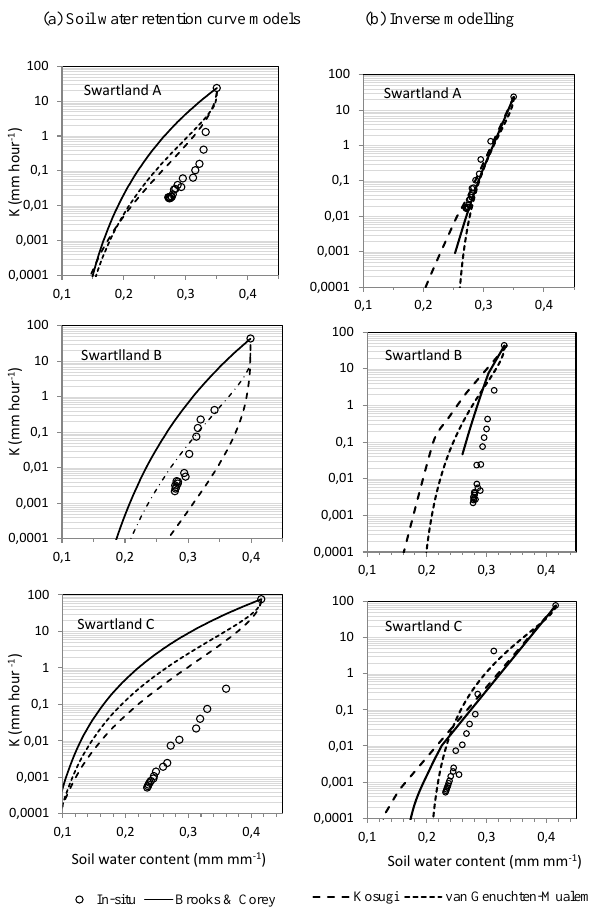
Fig. 7. Models predictions of in situ hydraulic conductivity based Figure 7 Models predictions of in-situ hydraulic conductivity based on the soil water on the retention curve and inverse modelling for the Swartland di- retention curve (a) and inverse modelling (b) for the Swartland diagnostic horizons. agnostic